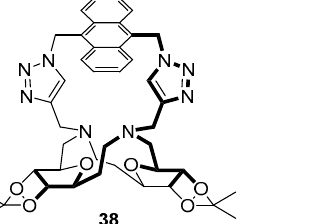
Figure 15. Crown ethers 35 – 37 have proved effective probes for monovalent cations. The tetrameric TPE derivative 35 shows a fluorescence enhancement in response to K + , forming a 1:2 35 ·K + complex in which each cation is sandwiched between two crown ether units [112]. The BODIPY-based systems 36 and 37 respond to Cs + [113].